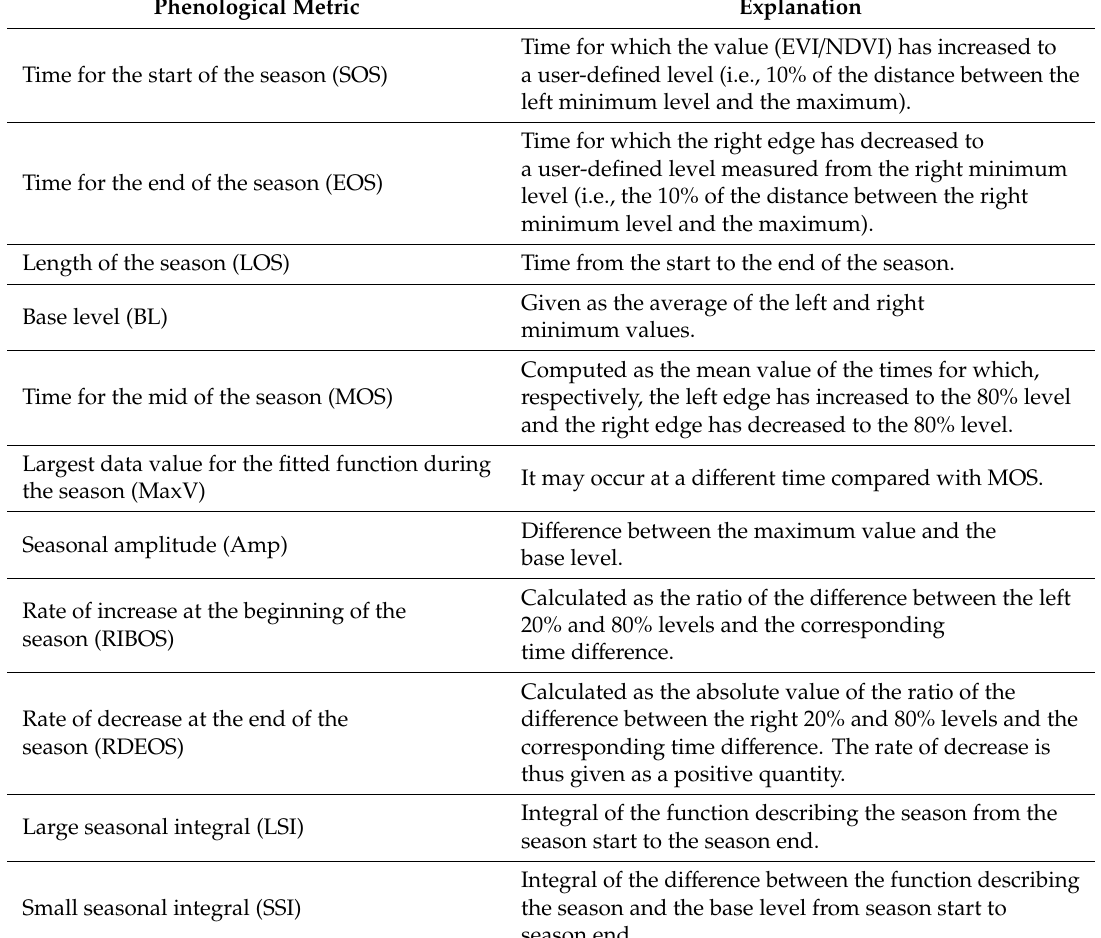
Table 1. Explanations of the extracted phenological metrics [32]. EVI: enhanced vegetation index, NDVI: normalized di ff erence vegetation